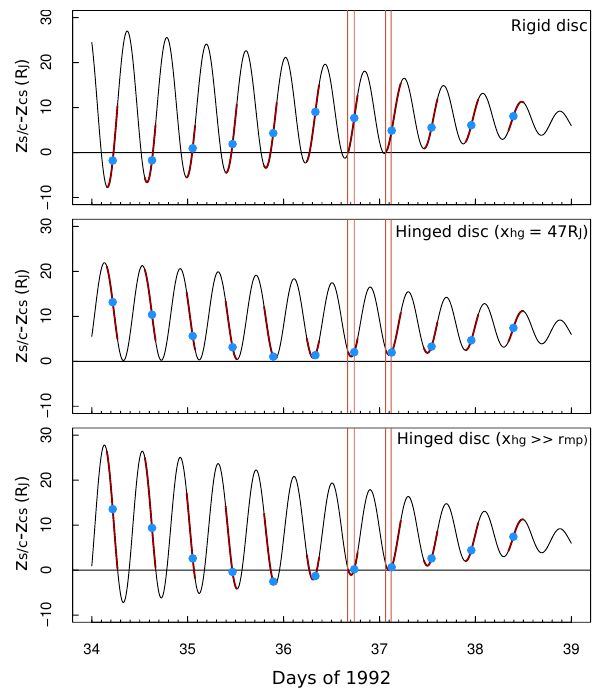
Fig. 12. The distance of Ulysses from the nominal current sheet (in units of Jovian radii) as a function of time for three different models. The top panel assumes a rigid current sheet, the middle panel a current sheet as described by the model of Khurana & Schwarzl (2005) using a standard hinging distance of x h = 47 R j , the bottom panel is the Khurana model using a neglectable hinging of the current sheet, i.e. a hinging distance being much larger than the sunward extension ofg the magnetopause ( r mp ) .